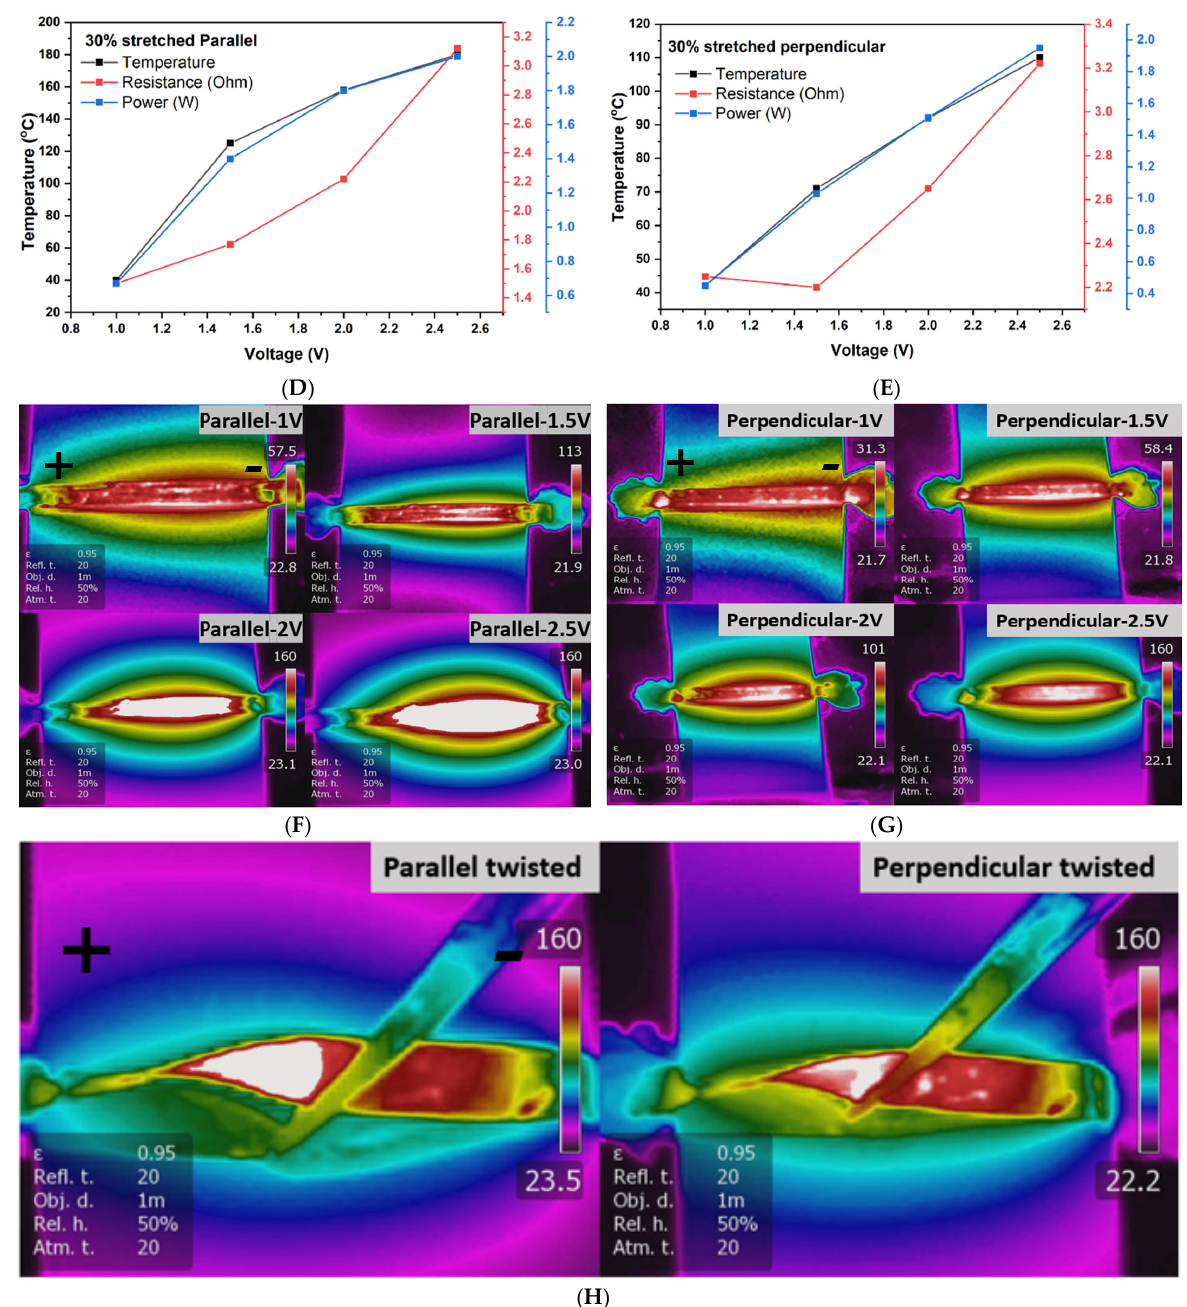
Figure 5. Heating performance of the 30% CSA-stretched CNT in parallel direction ( A ) and perpendicular direction ( B ); heating performance of the 30% stretched parallel sample over 120 cycles with the first and last two cycle performance ( C ); power-voltage-temperature-resistance plot for the 30% CSA-stretched CNT in parallel direction ( D ) and perpendicular direction ( E ); thermal images of the 30% CSA-stretched CNT in parallel direction ( F ), perpendicular direction ( G ), and with twisting movement ( H ).